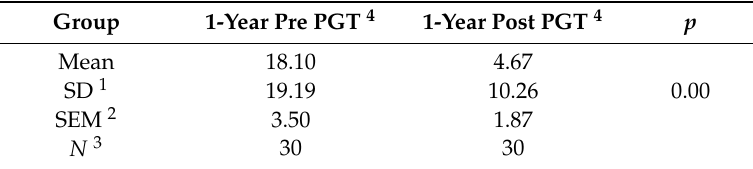
Table 3. Number of days of hospitalization: mirror analysis.